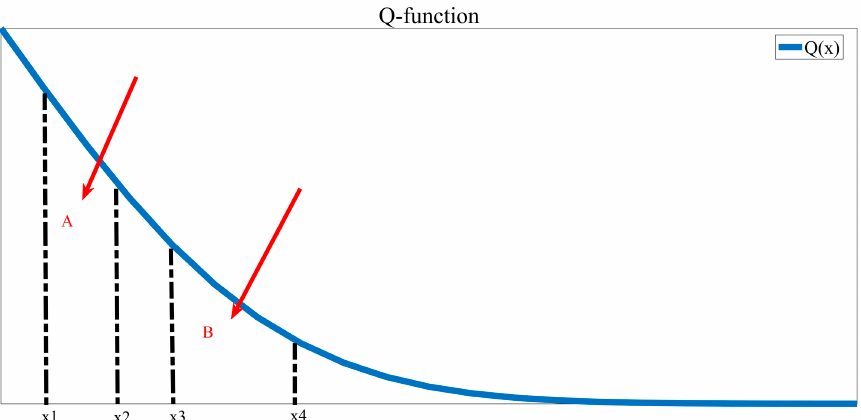
Figure A1. Q function graph.